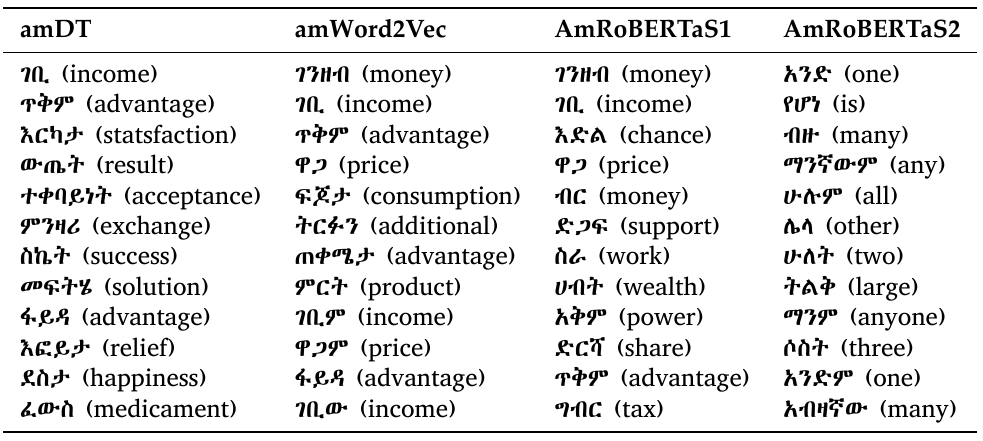
Table 4. Comparison of similar words generated from the AmDT, AmWord2Vec, and two contextu‑ alized suggestions from AmRoBERTa for the word ትርፍ. Columns AmRoBERTaS1 and AmRoBER‑ TaS2 show the the contextual suggestion for the <mask> word from Sentence1 and Sentence2